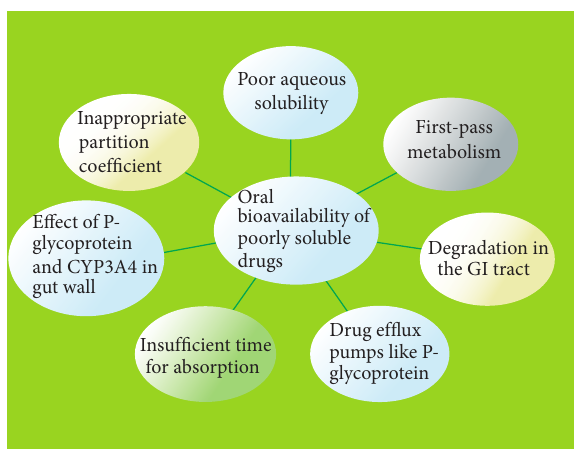
Figure 1: Reasons for poor oral bioavailability of poorly water soluble